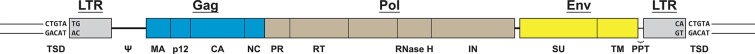
Schematic representation of the major features of ERV-Fc proviruses.The region colored in blue indicates gag, brown indicates pol, and yellow represents env coding regions. The gray-colored regions indicate the two long terminal repeat (LTR) regions. Vertical lines within these regions indicate where proteolytic cleavage would occur between protein subunits. The identity of these subunits is indicated below the schematic: MA = matrix, CA = capsid, NC = nucleocapsid, PR = protease, RT = reverse transcriptase, IN = integrase, SU = surface, TM = transmembrane, PPT = polypurine tract. The probable location of the viral RNA packaging motif is indicated by ψ. At the termini of the retroviral LTR sequences is shown the canonical TG/CA dinucleotides as well as the 5 nucleotide target site duplications (TSDs) flanking the provirus. ERV, endogenous retrovirus.